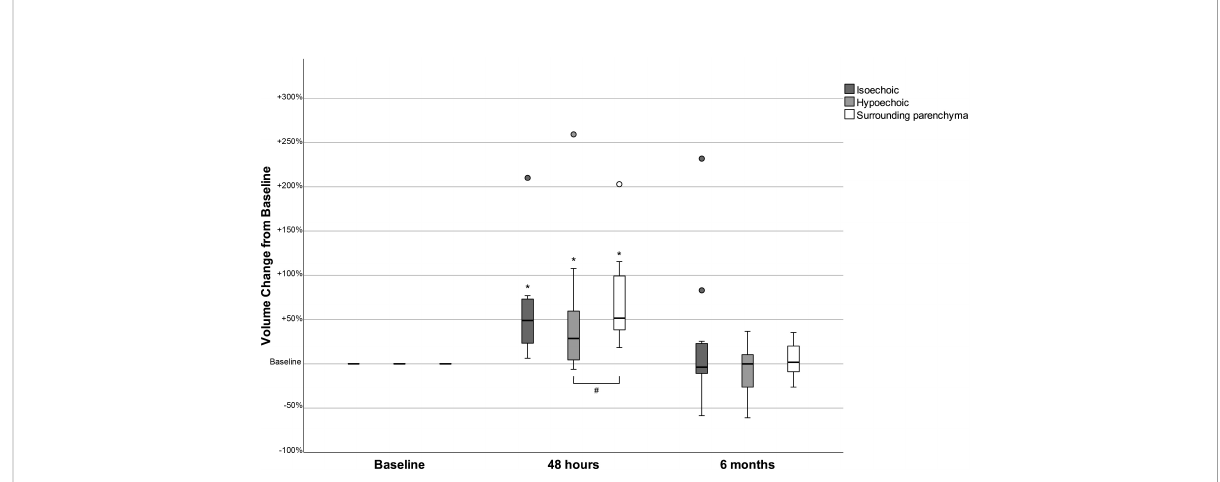
FIGURE 1 Changes in the volume of isoechoic and hypoechoic nodules and in the surrounding parenchyma volume 48 hours and 6 months after the administration of human recombinant TSH, presented as % change from baseline. *p<0.05 Volume at 48 hours versus baseline (Wilcoxon signed-rank test). p<0.05 Volume change from baseline (Mann-Whitney test) .